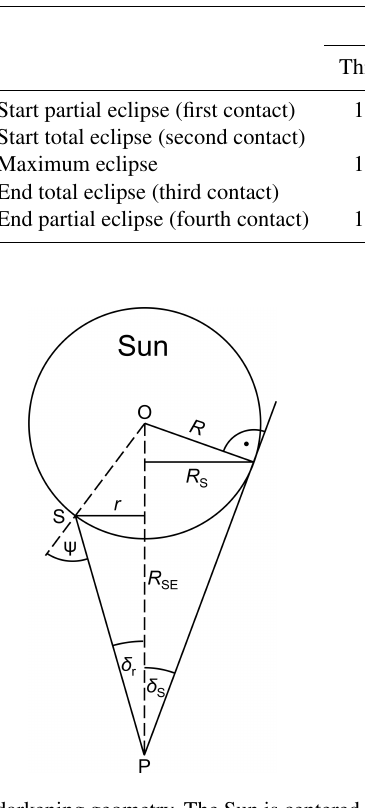
Figure 6. Limb darkening geometry. The Sun is centered at point O and has the radius R . The observer is at point P at a distance R SE from the center of the Sun and is looking at point S on the surface of the Sun. From the point of view of the observer, S is at an angle δ r relative to the center of the Sun, and the Sun’s limb is at angle δ S . The angular radius of the solar disk as viewed by the observer is R S , and the angular radius associated with S is r . ψ is the angle between the Sun’s normal at S and the line between S and